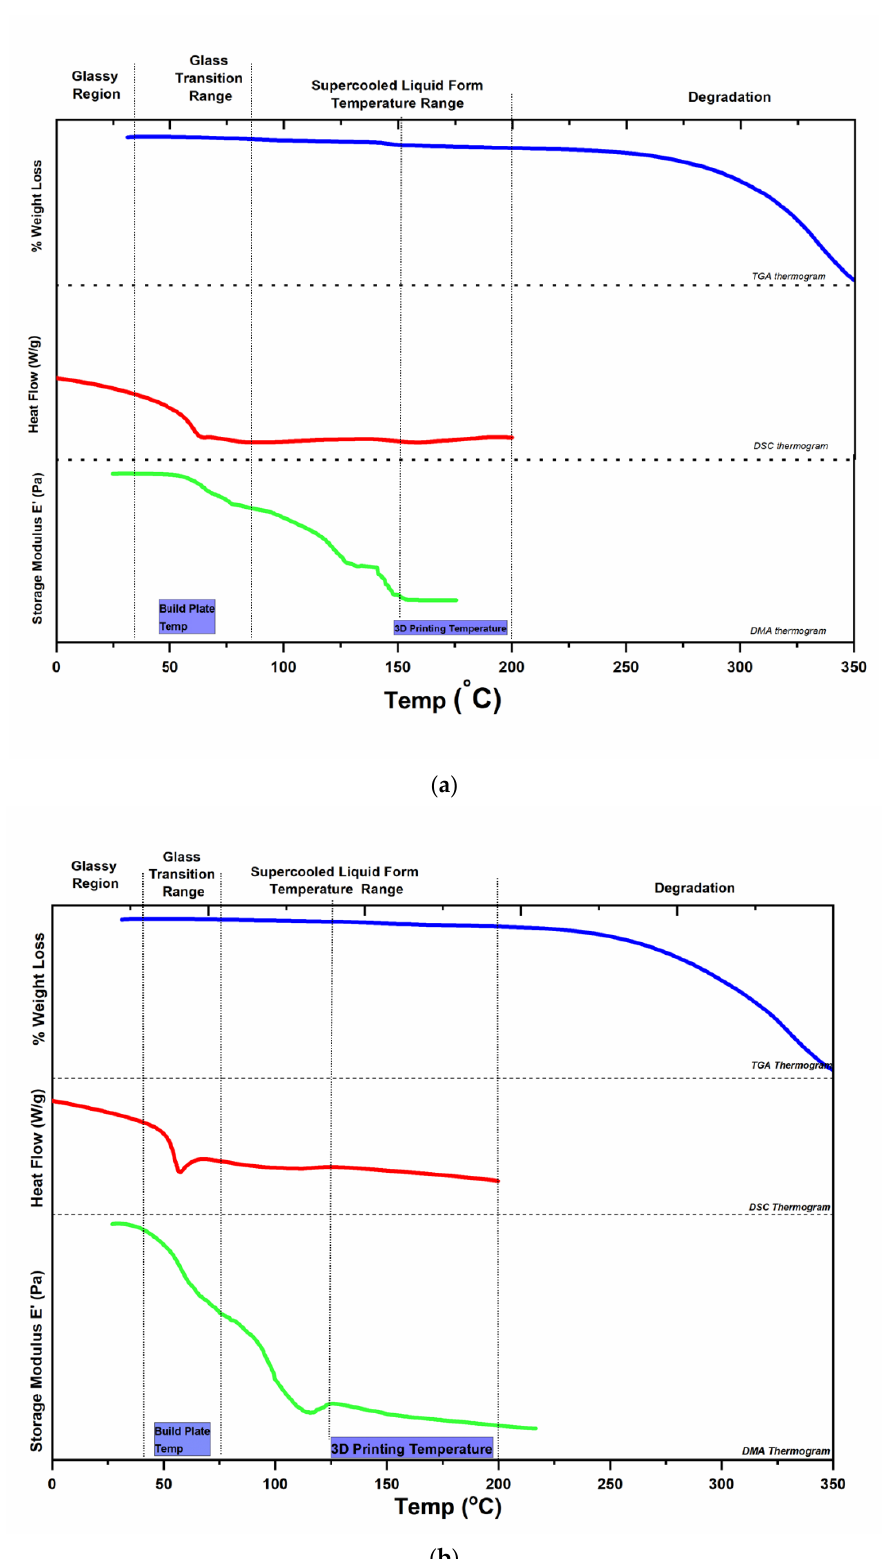
Figure 2. Temperature profile obtained by plotting TGA, DSC, and DMA thermograms of ( a ) 20% NAP and ( b ) 30% NAP filaments together for the selection of 3D printing temperature and build-plate temperature. Dash and dotted lines guide the eye to the various thermograms and temperature regions,